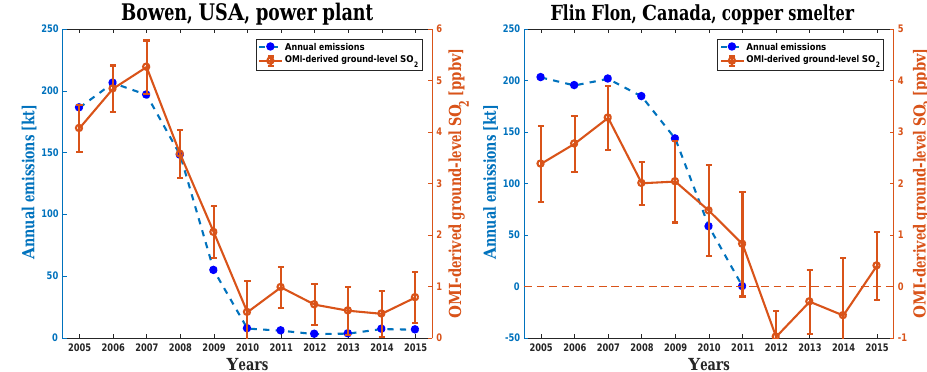
Figure 6. Time series of bottom-up annual SO 2 emissions and OMI-derived ground-level SO 2 concentrations for Bowen power plant (34.13 ◦ N, 84.92 ◦ W), USA, and Flin Flon copper smelter (54.77 ◦ N, 101.88 ◦ W), Canada. The dashed orange line represents the zero line in the Flin Flon, Canada, plot. Bottom-up SO 2 emissions data are not available after 2011 due to the closure of Flin Flon copper smelter. The error bars represent the 1 standard error of the mean.